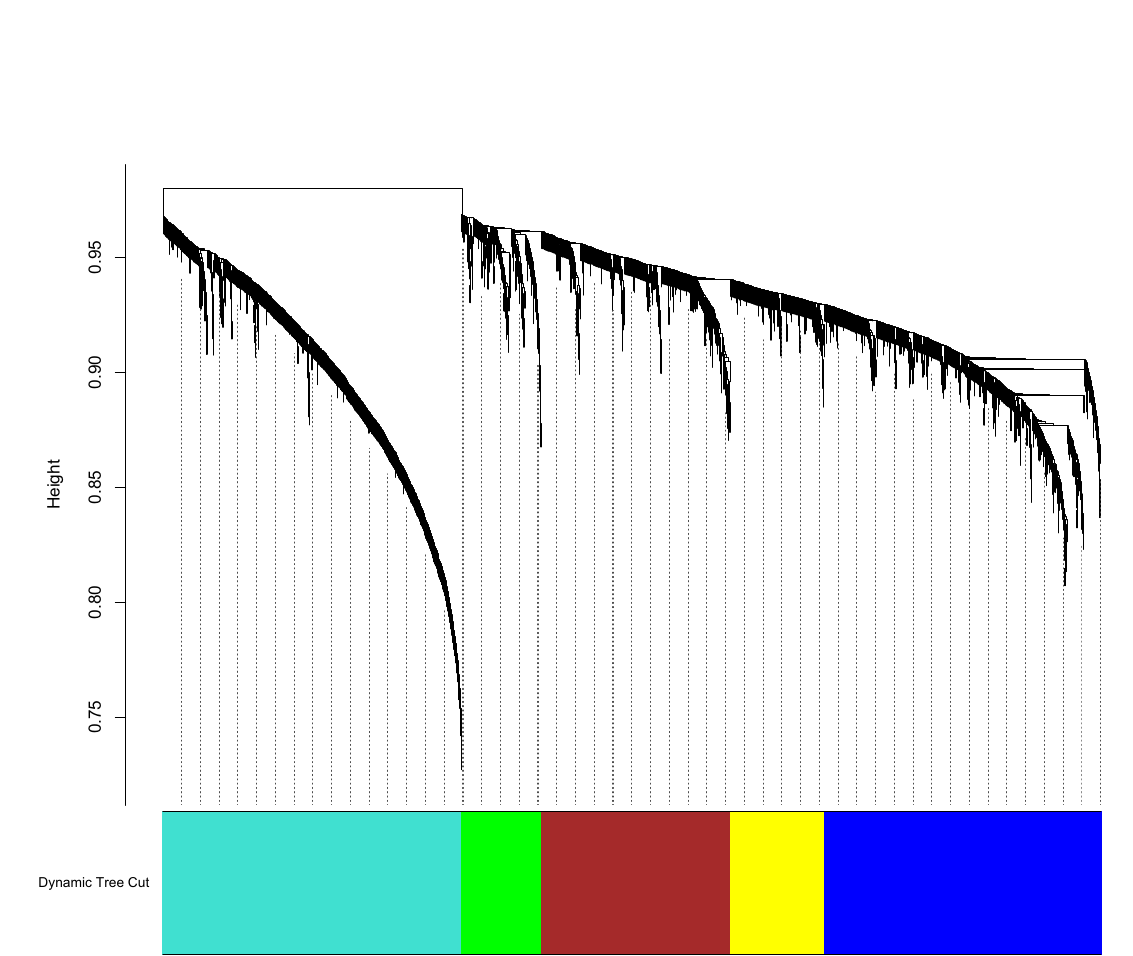
Figure 4. Weighted gene co-expression network analysis (WGCNA) of differentially expressed genes (DEGs). Cluster dendrogram showing co-expression modules identified by WGCNA. The modules are denoted in the colour